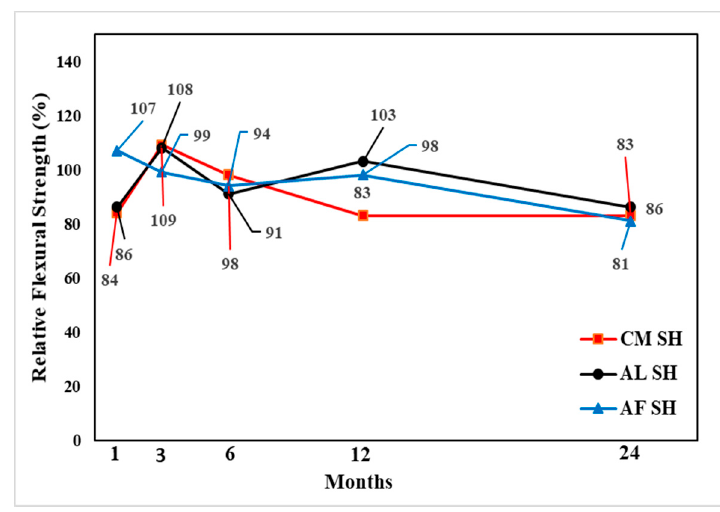
Figure 20. Relative Flexural strength (%) by accelerators specimens with SH.